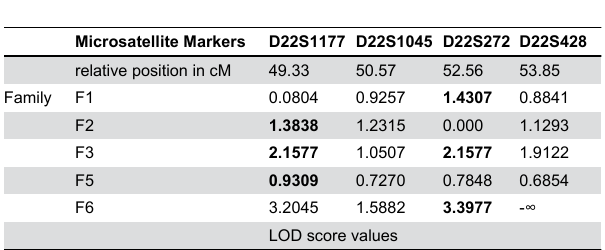
Table 6. Allegro software results of Multipoint LOD score values of four markers flanking the PLA2G6